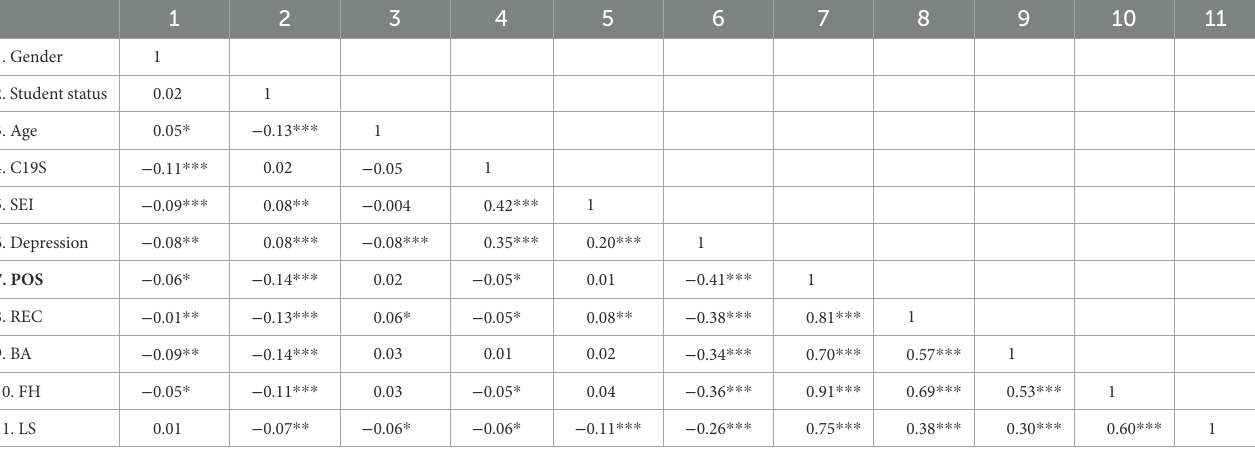
TABLE 3 Correlations among